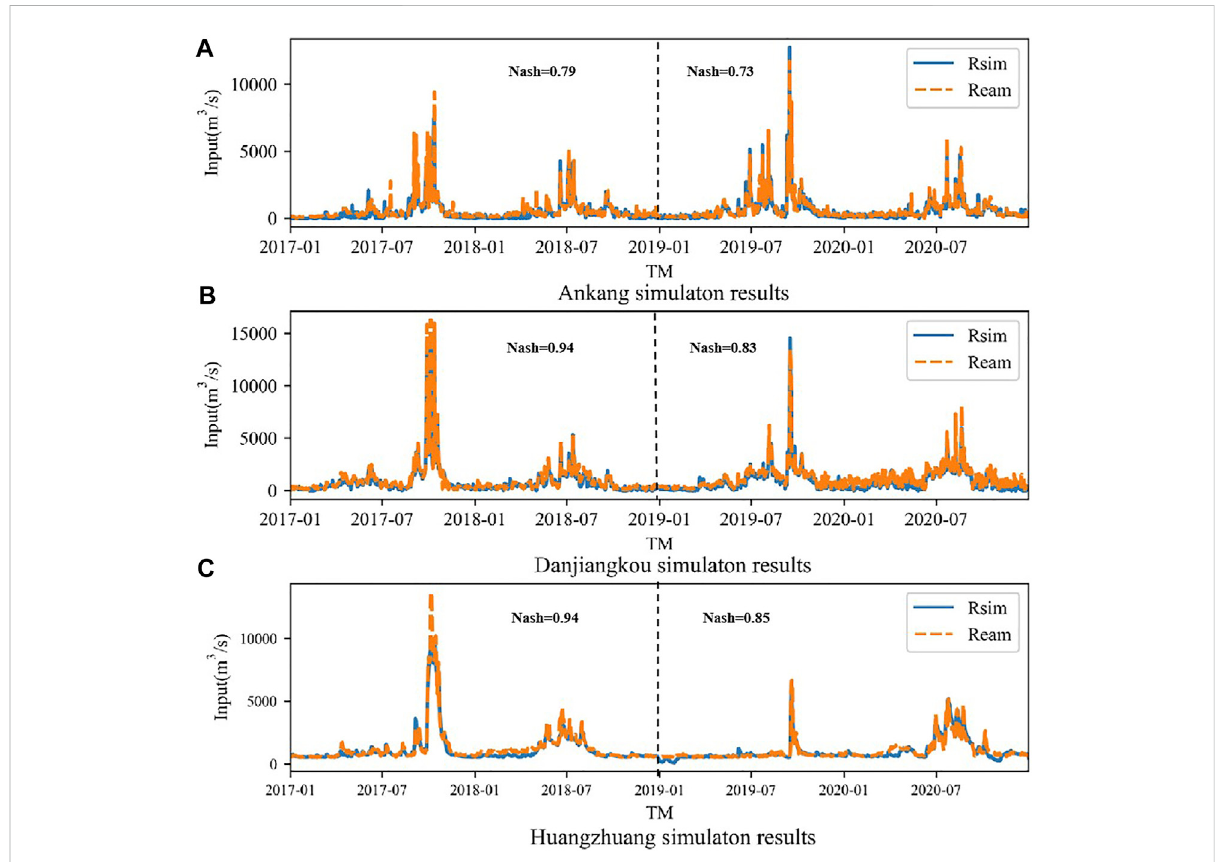
FIGURE 7 Simulation results of three section rates at calibration and validation periods (m 3 /s). (A – C) are the simulation results of Ankang, Huangjiagang and Huangzhuang